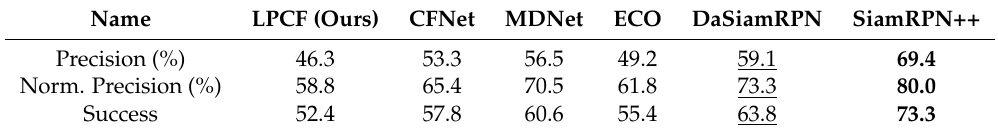
Table 4. Comparison with state-of-the-art trackers on the test set of TrackingNet (511 sequences) in terms of precision, normalized precision and success (AUC). The best results and second highest values are highlighted by bold and